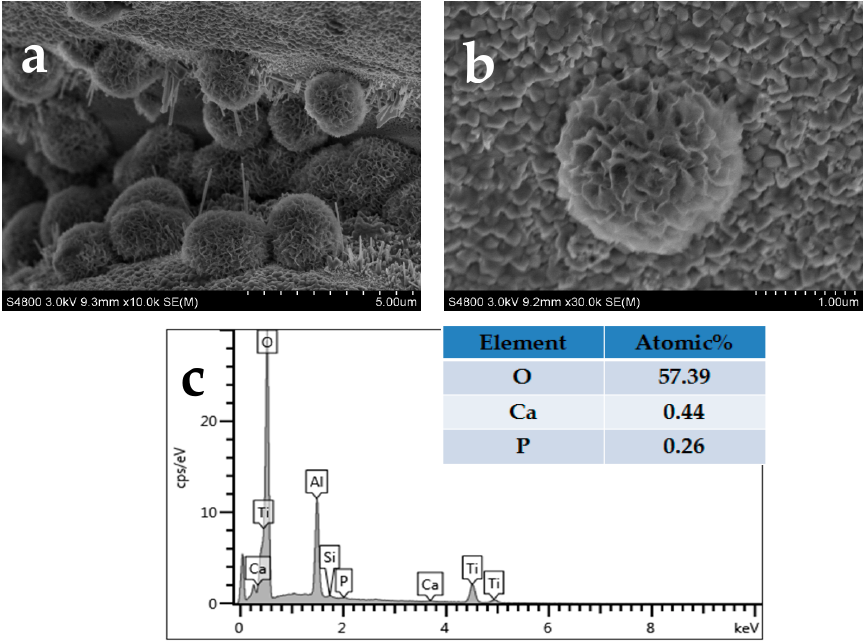
Figure 5. SEM surface morphology ( a , b ) of the MBG-coated Ti-6Al-4V scaffolds soaked in SBF for seven days and EDS analysis ( c ) of the flaky structure.